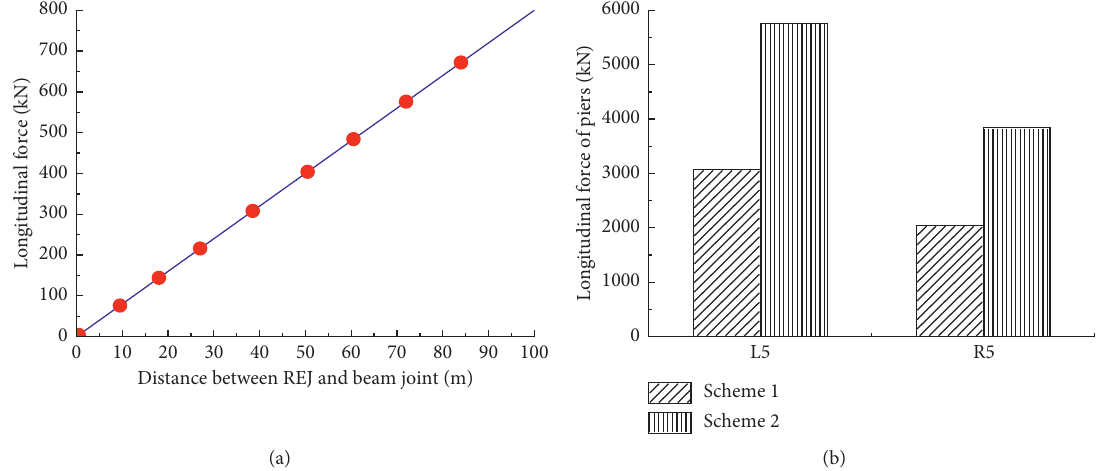
Figure 10: Rail longitudinal force and adjacent pier longitudinal force. (a) Rail longitudinal force at the end of the beam. (b) Adjacent pier longitudinal